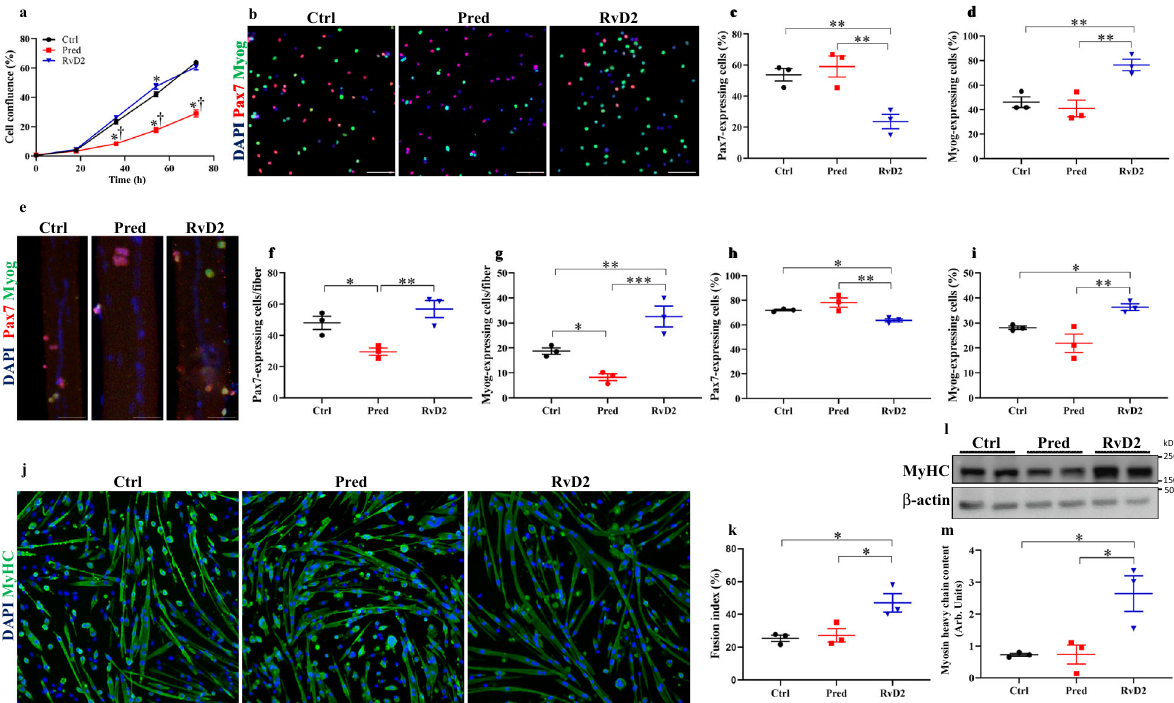
Fig. 2 Resolvin-D2 directly targets myogenic cells and stimulates their myogenesis capacity. a Primary myoblasts isolated from mdx mice were plated in vitro in an automated live imaging analysis system (IncuCyte). Cells were cultured in proliferation media supplemented with Resolvin-D2 (RvD2, 200 nM, blue triangles), prednisone (pred, 10 μ M, red squares), or vehicle (Ctrl, black circles), and cell con fl uence was assessed for 3 days (36 h: Ctrl vs. Pred, p < 0.0001; Ctrl vs. RvD2, p = 0.1352; Pred vs. RvD2, p < 0.0001; 54 h: Ctrl vs. Pred, p < 0.0001; Ctrl vs. RvD2, p = 0.0084; Pred vs. RvD2, p <